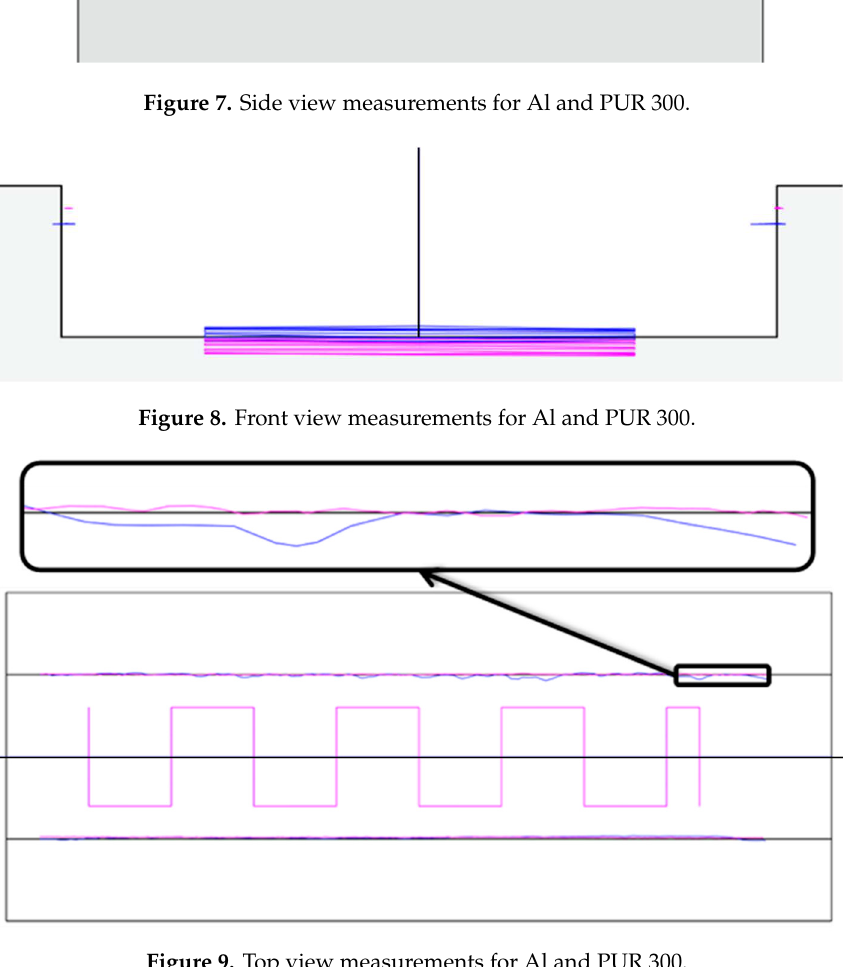
Figure 7. Side view measurements for Al and PUR 300.